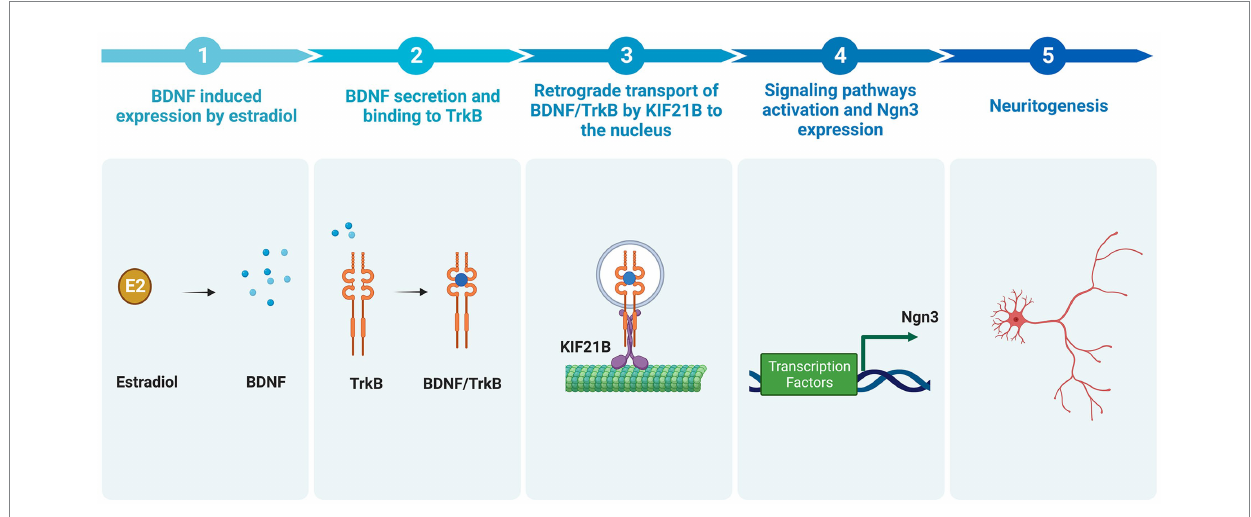
FIGURE 8 Summary of the newly proposed pathway by which estradiol increases neuritogenesis (Created with BioRender.com). Estradiol increases the expression of BDNF in hippocampal neuronal cultures. BDNF binds to the TrkB receptor. The complex BDNF/TrkB is endocytosed and transported retrogradely by kinesin KIF21B to the soma leading to the activation of signaling pathways, which enhances Ngn3 mRNA and protein level, thus increasing